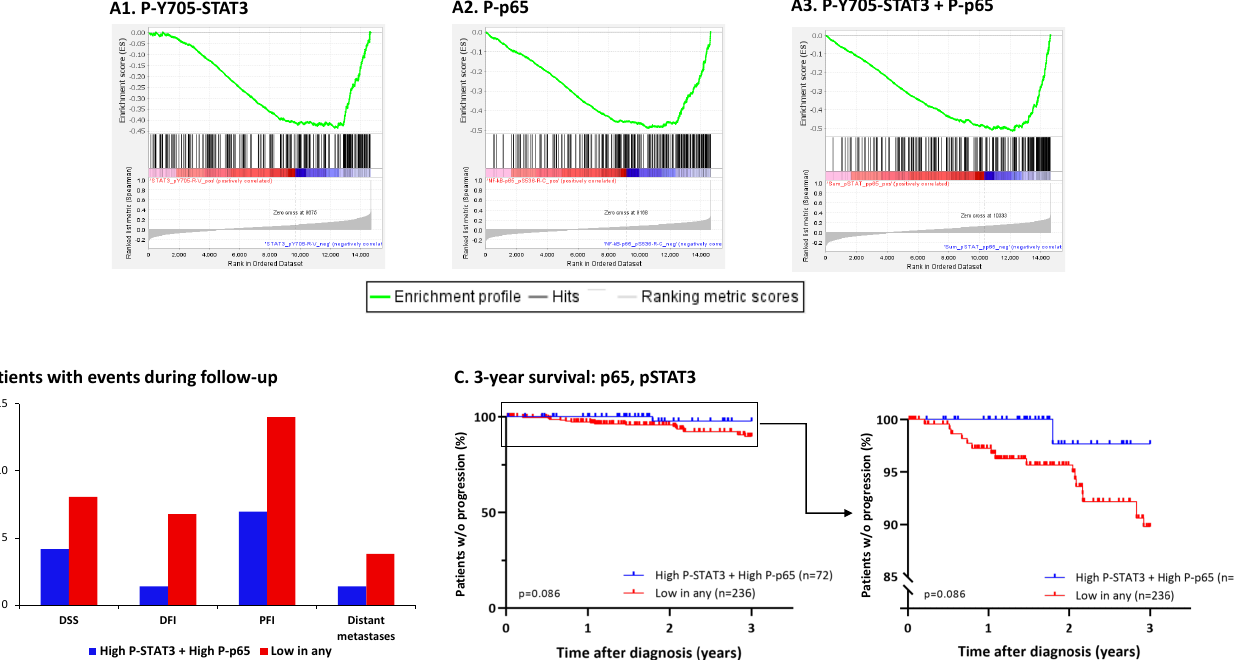
Figure 14. Clinical data of luminal A patients point at correlation of Y705-STAT3 activation + p65 activation with reduced CSC gene signatures and improved patient survival: mRNA, phospho- proteomics and clinical data of 308 samples of luminal A patients from the TCGA database were analyzed. ( A ) Gene set enrichment analyses (GSEA) for correlation between a CSC gene signature